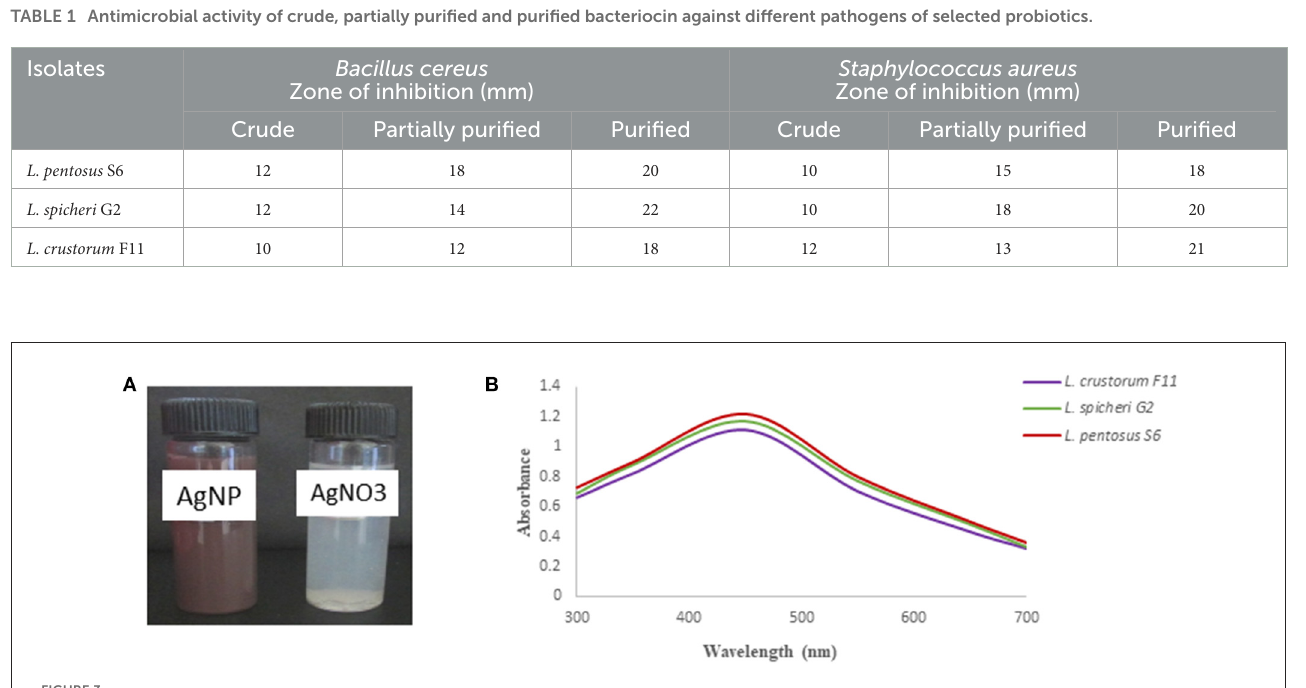
FIGURE3 (A) synthesis of AgNP s was confirmed by color change in the solution after incubation. (B) UV-vis spectroscopy analysis of synthesized AgNP s using different